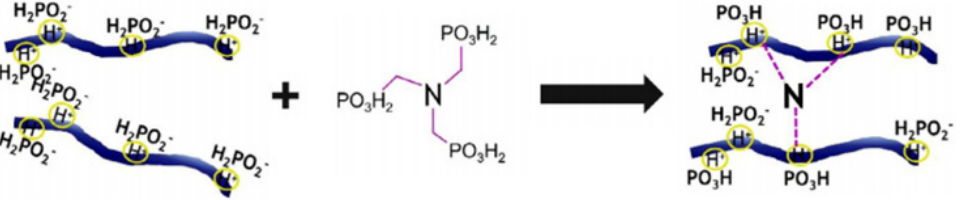
Figure 2. Schematic illustration of crosslinking reaction between chitosan and nitrilotris (methylenephosphonic acid) (NTMP) [58].